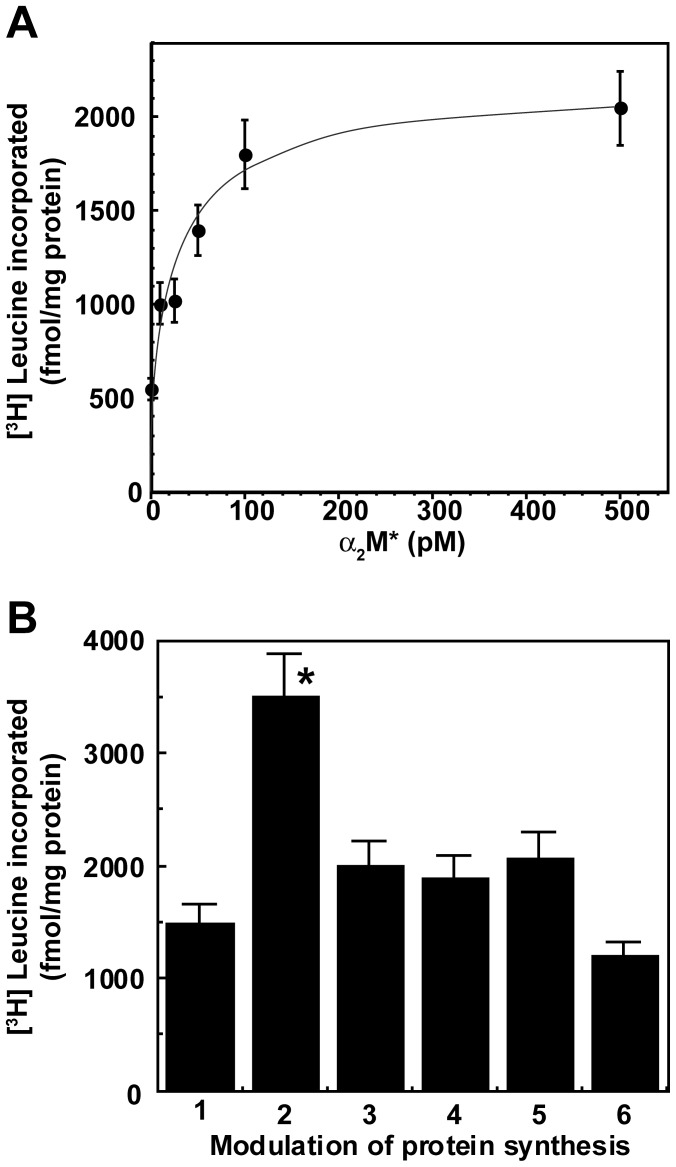
α2M*-induced protein synthesis and its sensitivity to rapamycin in 1-LN prostate cancer cells.
Panel A. α2M* concentration-dependent protein synthesis. Panel B. Modulation of α2M*-induced-protein synthesis in 1-LN cells. The bars are: (1) buffer; (2) α2M* (50 pM); (3) wortmannin 30 nM/20 min then α2M* (50 pM); (4) LY294002 (20 µM/20 min) then α2M*; (5) Rapamycin (100 nM/20 min), then α2M*; (6) Actinomycin D (5 µg/ml/15 min) then α2M*. The values in Panel A and B are the mean ± SE from four independent experiments. Values significantly different at 5% level for α2M*-treated cells marked by an asterisk (*).